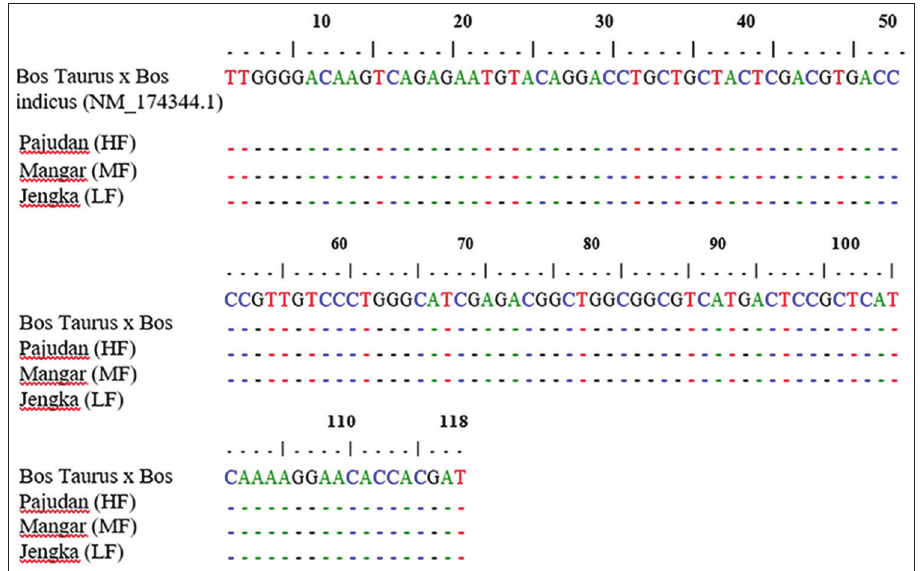
Figure-4: Sequence alignment of the heat shock protein ( HSP)70-2 gene in frozen semen of Madura cattle post-thawing using MEGA 7 version 0.26 [Source: Rosyada et al ., unpublished data].